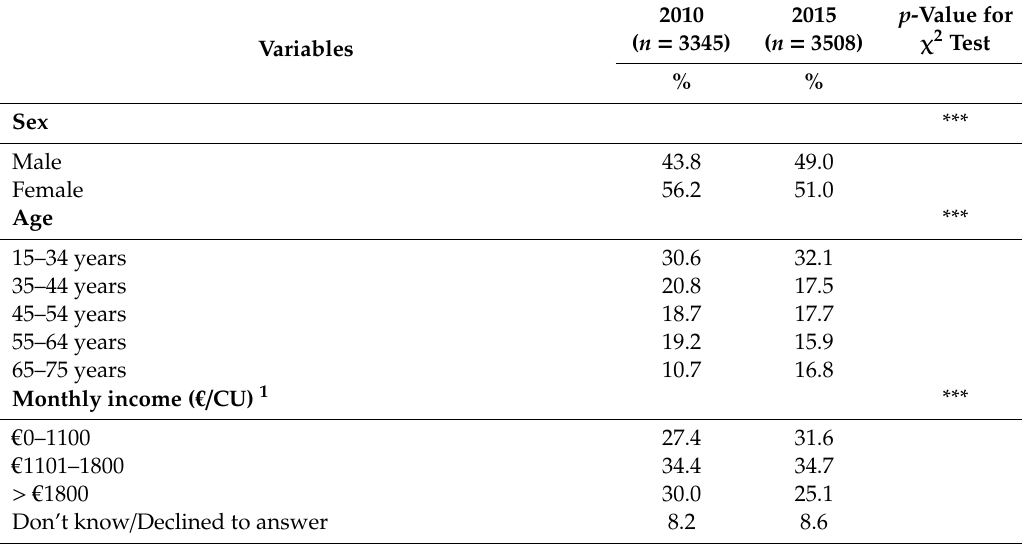
Table 2. Participant characteristics for 2010 and 2015 Cancer Barometer